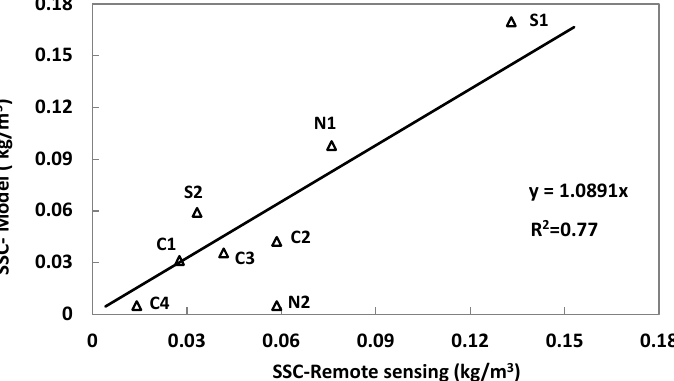
Figure 10. The correlation between simulated SSC and remote sensing data at selected points.